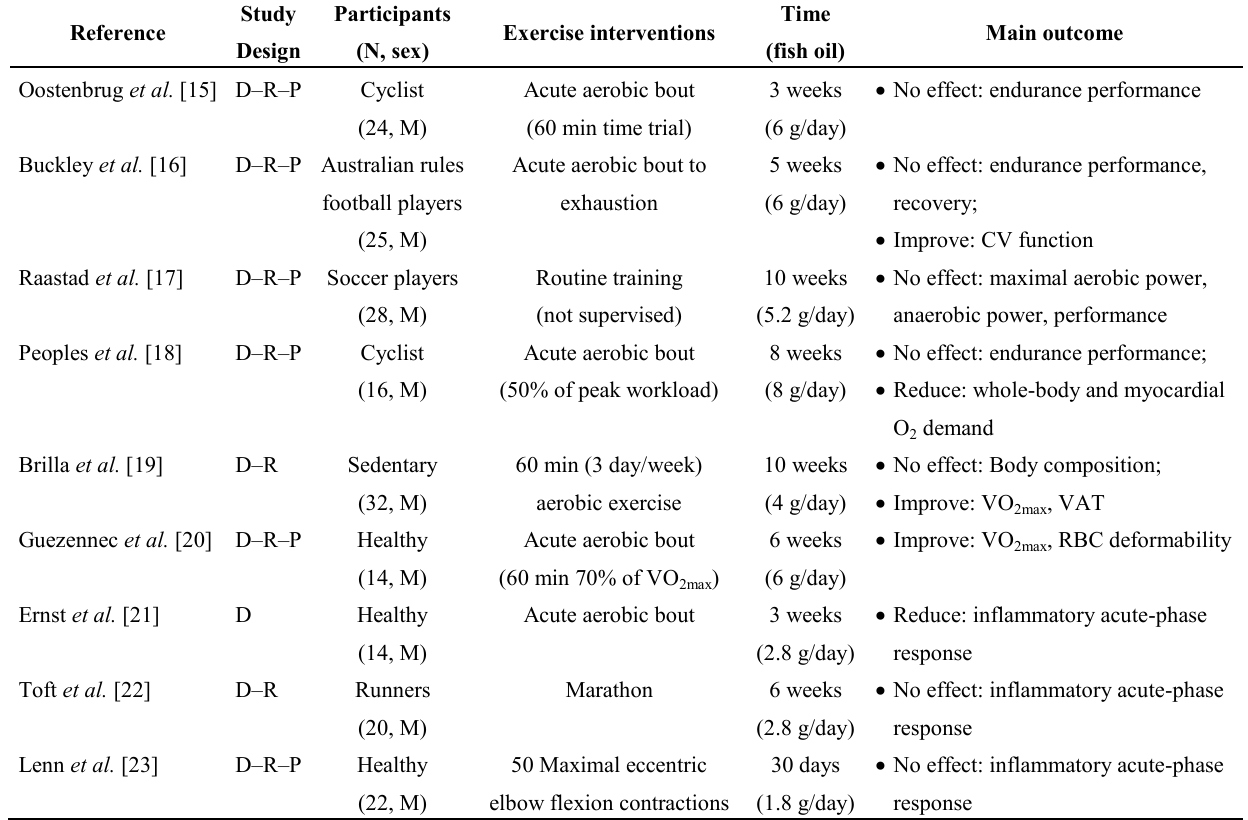
Table 1. Effects of fish oil supplementation associated with exercise.